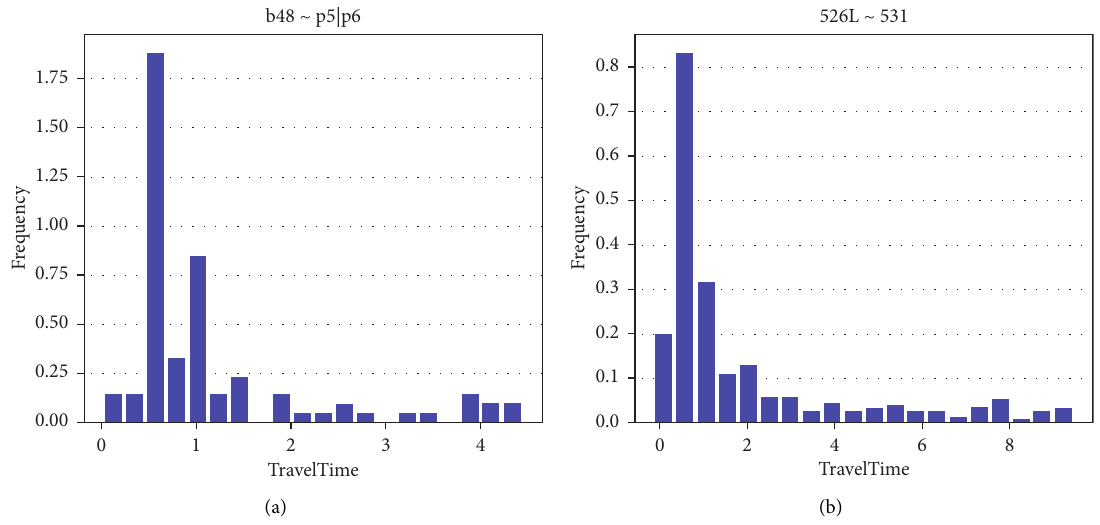
Figure 9: Histogram of OD distance distribution from b48 to p 5| p 6 (a) and 526L to 531 (b).